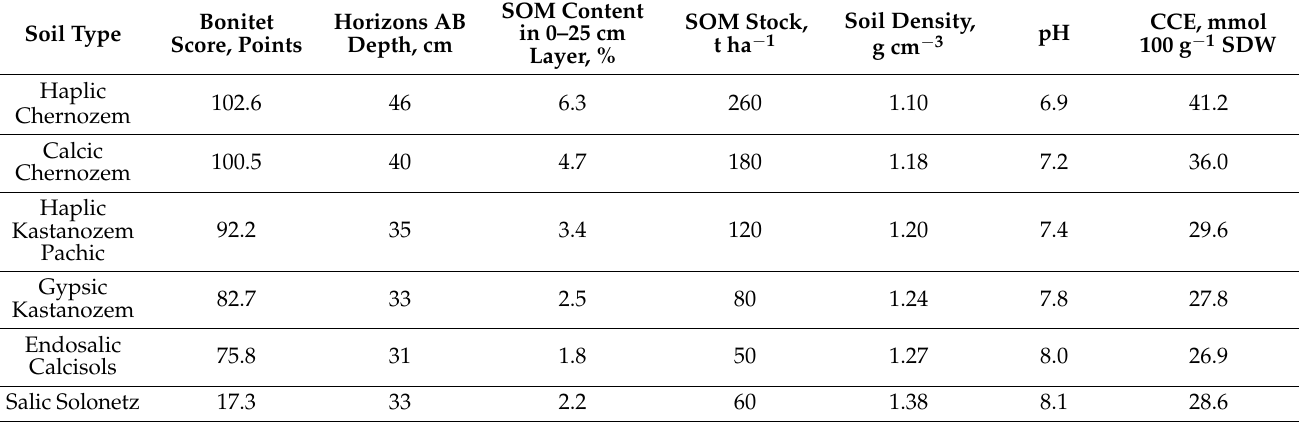
Table 2. Soil properties.